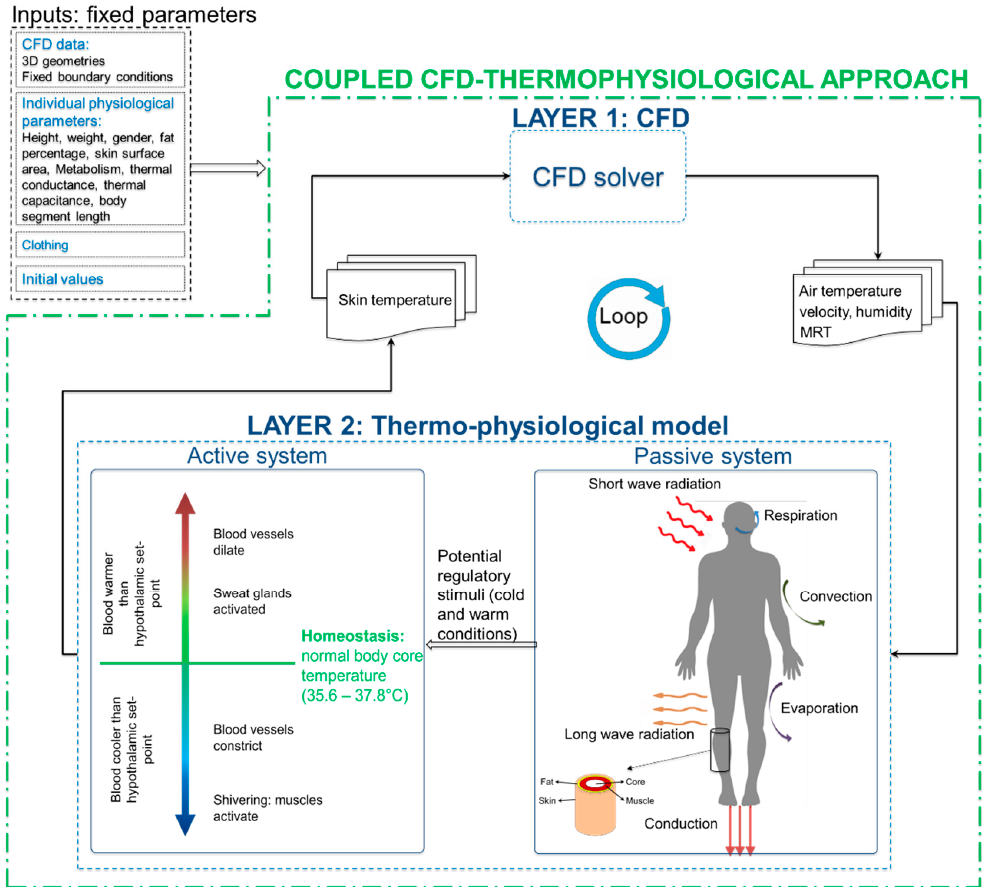
Figure 5. Coupled CFD solver and thermophysiological model interface. Outputs from the CFD and the thermophysiological model are acquired after some internal iterations and convergences. In each iteration of the coupled model, the CFD and the thermophysiological model generate a new set of values for another model (Human icon made by Freepik from www.flaticon.com).